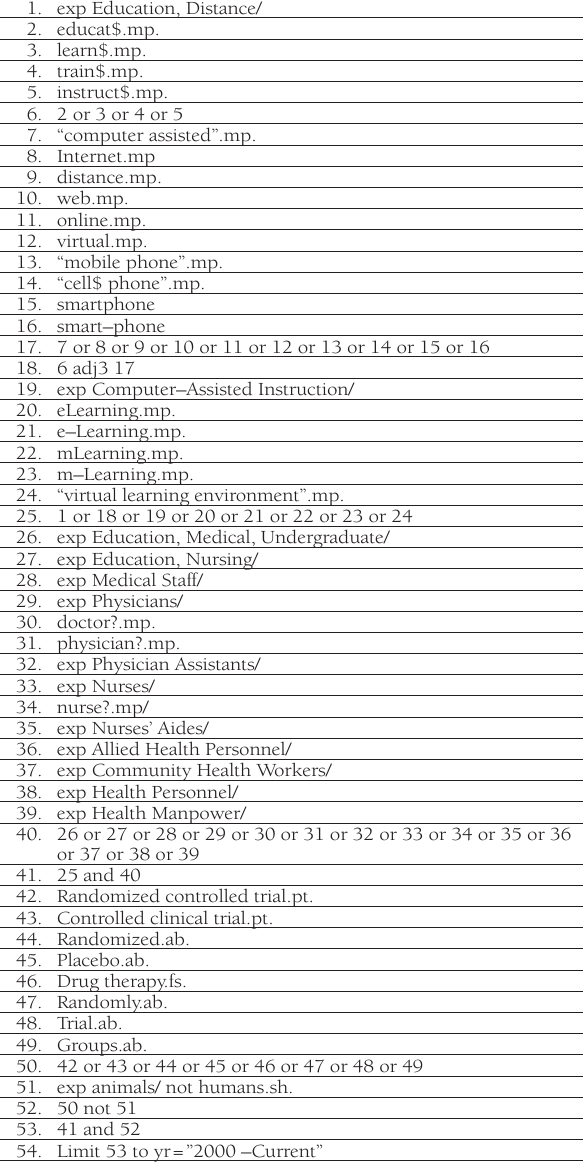
Table 1. Search strategy for use in MEDLINE (Ovid